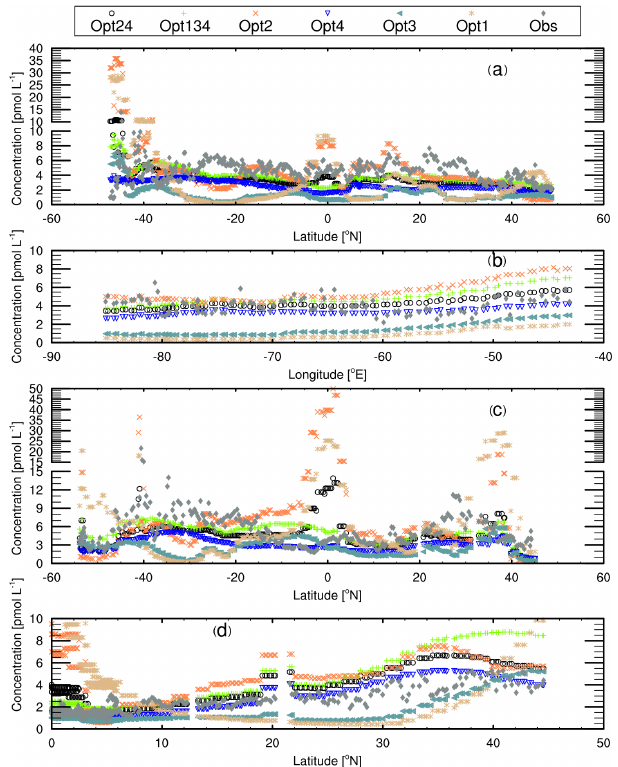
Figure 9. Observed and modeled methyl iodide concentrations (pmolL − 1 ). Observations are from Butler et al. (2007) ( a : BLAST 2, b : Gas Ex 98, c : BLAST 1, d : Phase 1-04. See also Figs. S1, S8, S10, and S11 in the Supplement). Note the broken y axes in (a) and (c)